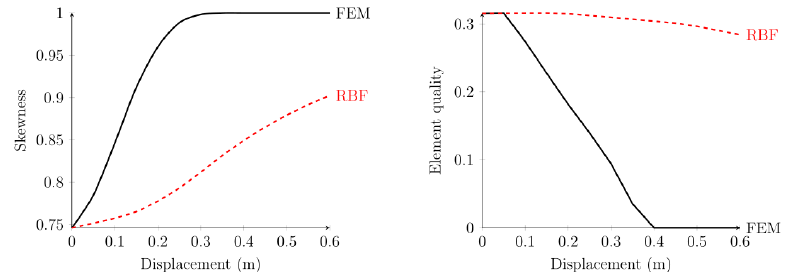
Figure 5. Mesh quality with respect to cube displacement for the case shown in Figure 4. Mean skewness ( left ) and element quality ( right )